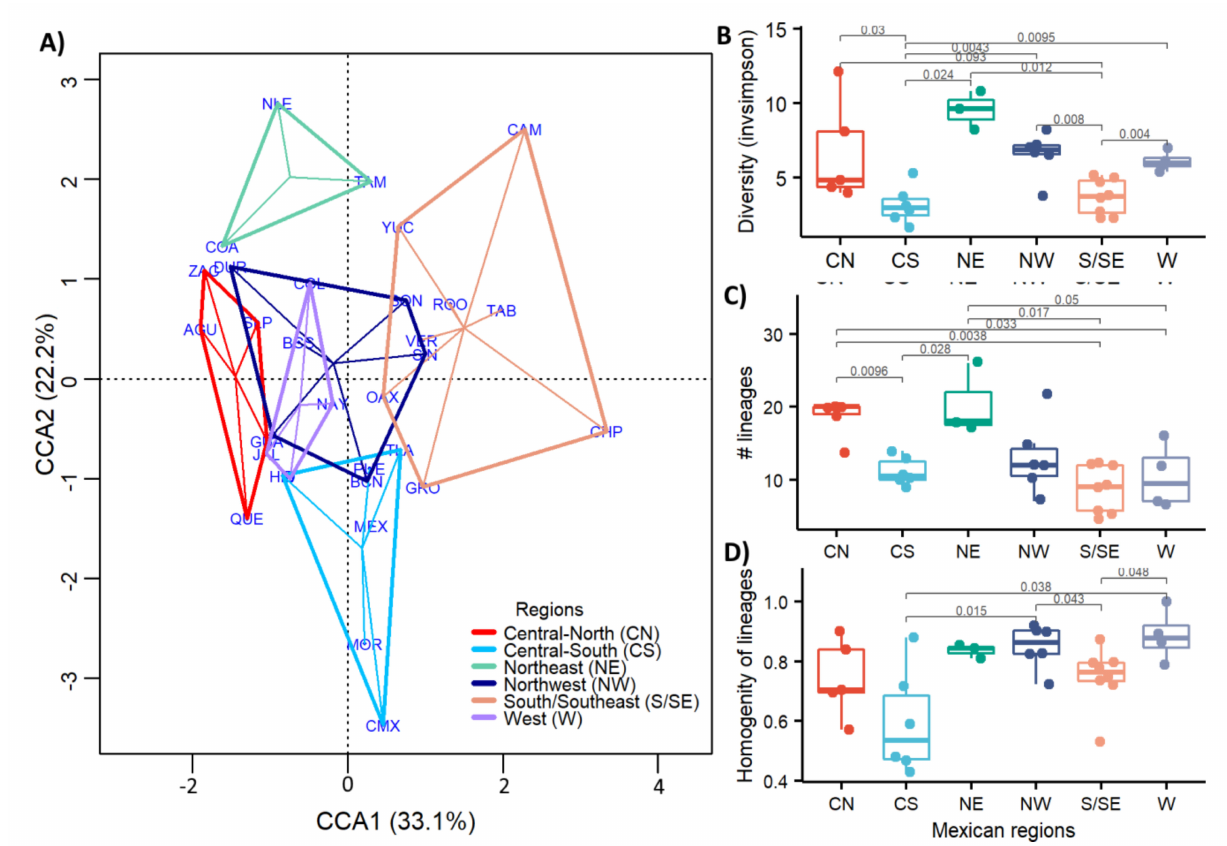
Figure 7. Diversity of lineage transmission comparison among the six regions along the year. ( A ) Canonical correlation analysis (CCA) of the different lineages. ( B ) Variant diversity index (H) by region. ( C ) Number of different lineages in each region. ( D ) Relative abundance (homogeneity) of lineages by